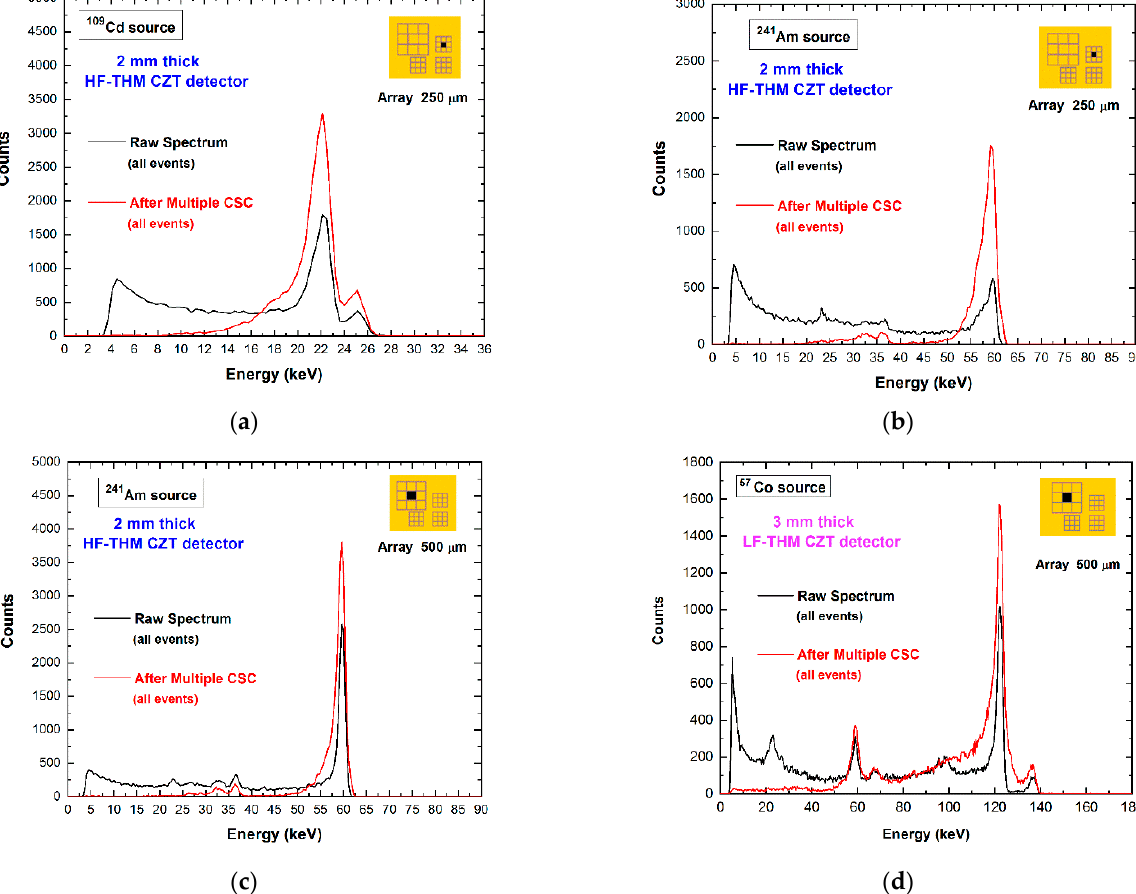
Figure 11. The raw energy spectra (black lines) and the corrected spectra (red lines) after the multiple charge-sharing correction (CSC) of the central pixel of 500/250 µ m arrays for different detectors: ( a – c ) the high-flux HF-THM CZT detector, ( d ) the low-flux LF-THM CZT detector. We applied the double CSC technique on m = 2 events between adjacent pixels, the standard CSA for m = 2 events between diagonal pixels, and the re-calibrated CSA for both m = 3 and m = 4 events. The energy resolution was slightly improved.